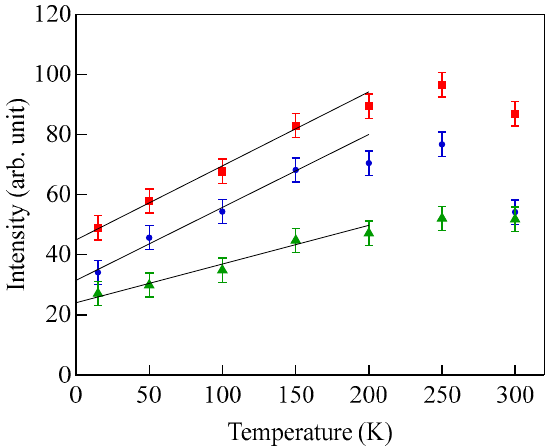
Figure 40. The peak intensities of the SPM excitations as a function of temperature: ( • ) bulk‑type anti-Stokes peak, ( ■ ) bulk-type Stokes peak, and ( ▲ ) DE-type peak. The solid lines are the least-squares fits to the linear function I ( T ) = A + B · T below 150 K [108].